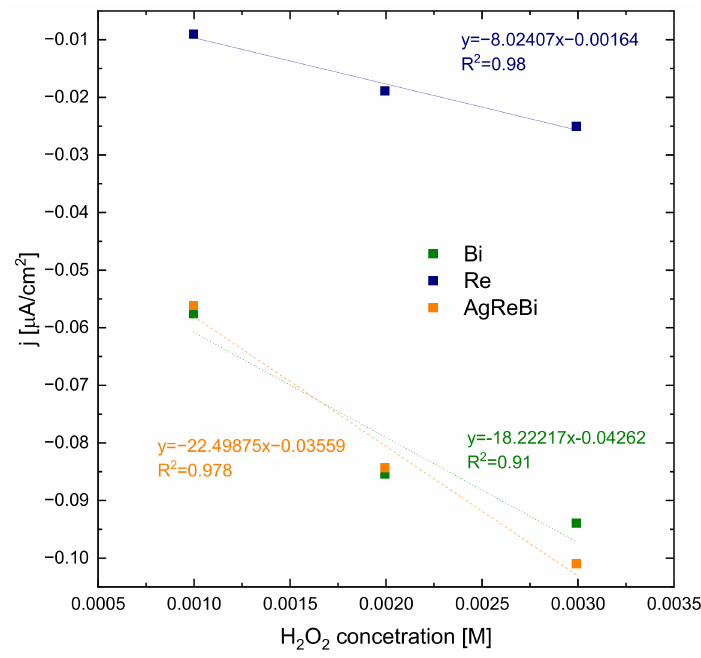
Figure 18. The calibration curves between the current density and H 2 O 2